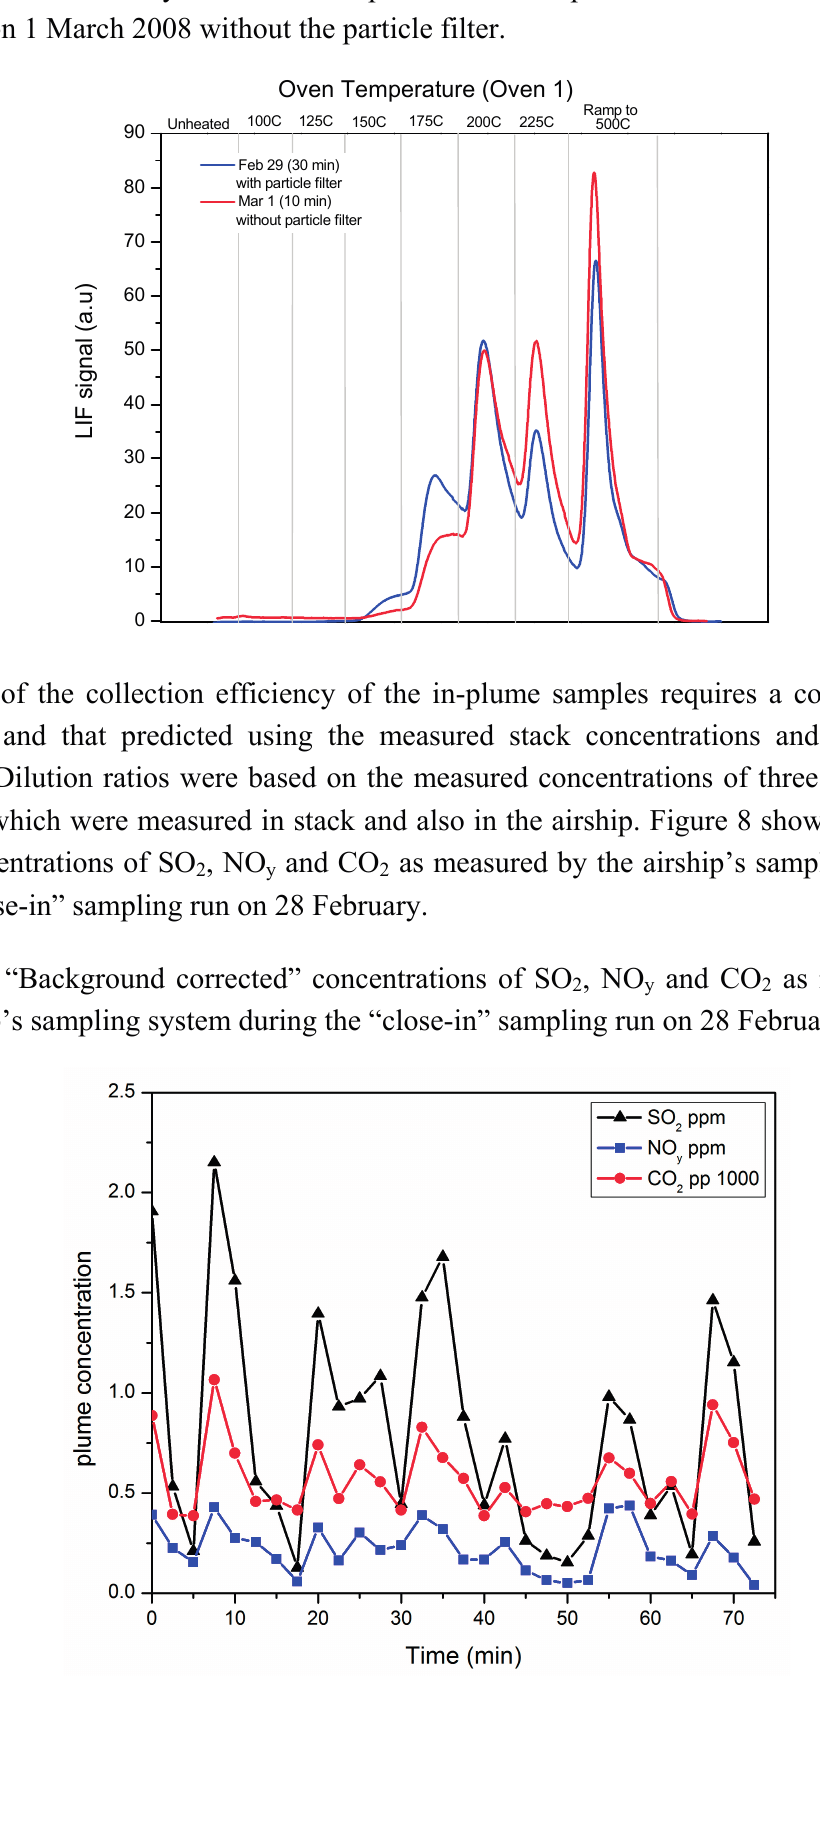
Figure 7. Comparison of PTD profiles (using Oven 1 program) of a 30 min stack sample obtained on 29 February 2008 with the particle filter in place and a 10 min stack sample obtained on 1 March 2008 without the particle filter.